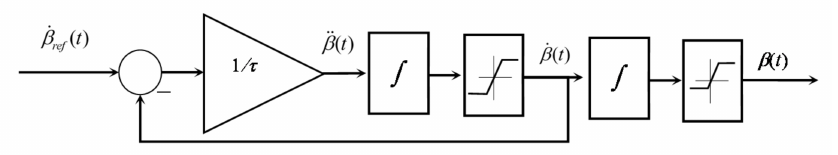
Figure 18. First order model of the pitch actuator with pitch rate set